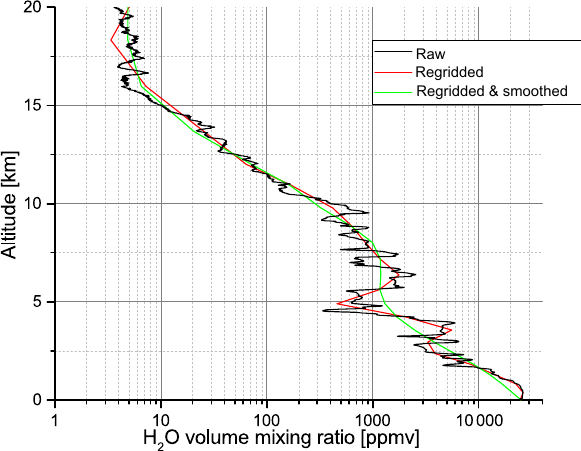
Figure 10. Example of the regridding and smoothing of the GRUAN data required before validating the MUSICA IASI retrieval of H 2 O profiles. Black line: raw GRUAN data. Red line: regridded GRUAN data ( g ). Green line: regridded and smoothed radiosonde data ( ˆ g , according to Eq.